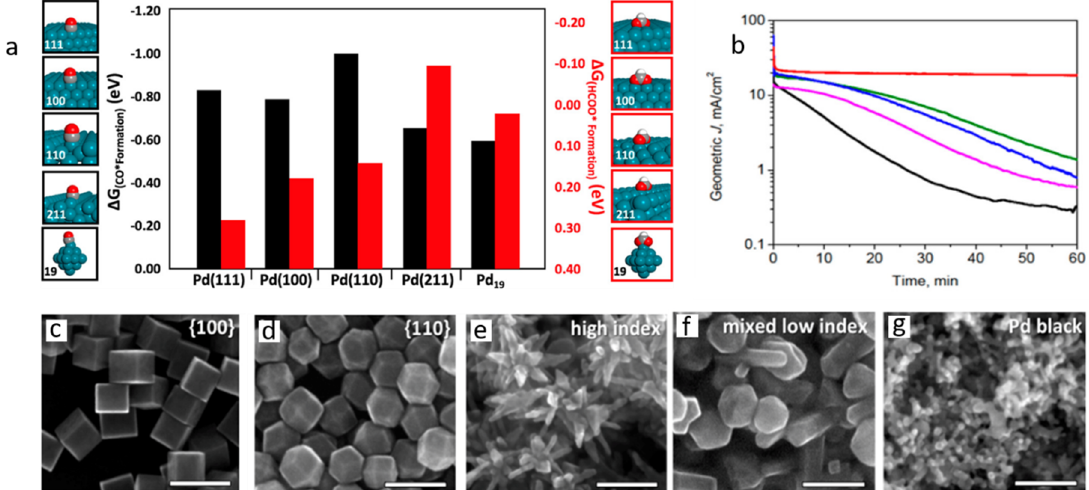
Figure 2. ( a ) Free energies of formation for *HCOO and CO* intermediates on Pd(111), Pd(100), Pd(110), Pd(211), and Pd 19 . The formation energy of the CO* intermediate is reduced and the formation energy of the *HCOO intermediate is increased on higher-index surfaces; ( b ) geometric current densities of CO 2 electroreduction; scanning electron microscopy (SEM) images of Pd nanoparticles (NPs): ( c ) {100} plane-enclosed nanocubes (NCs), ( d ) {110} plane-enclosed rhombic dodecahedra (RDs), ( e ) branched nanoparticles (BNPs) enclosed by high-index facets, ( f ) NPs with mixed low-index facets, and ( g ) Pd black. [53] Copyright 2016, ACS.